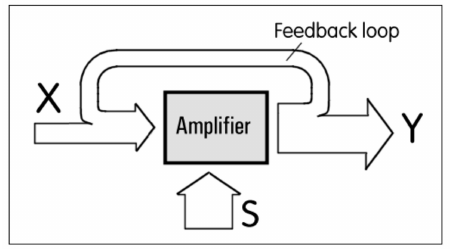
Figure 8. Schematic representation of flows in a fluidic general feedback loop: a part of the output flow Y is returned to the input X.